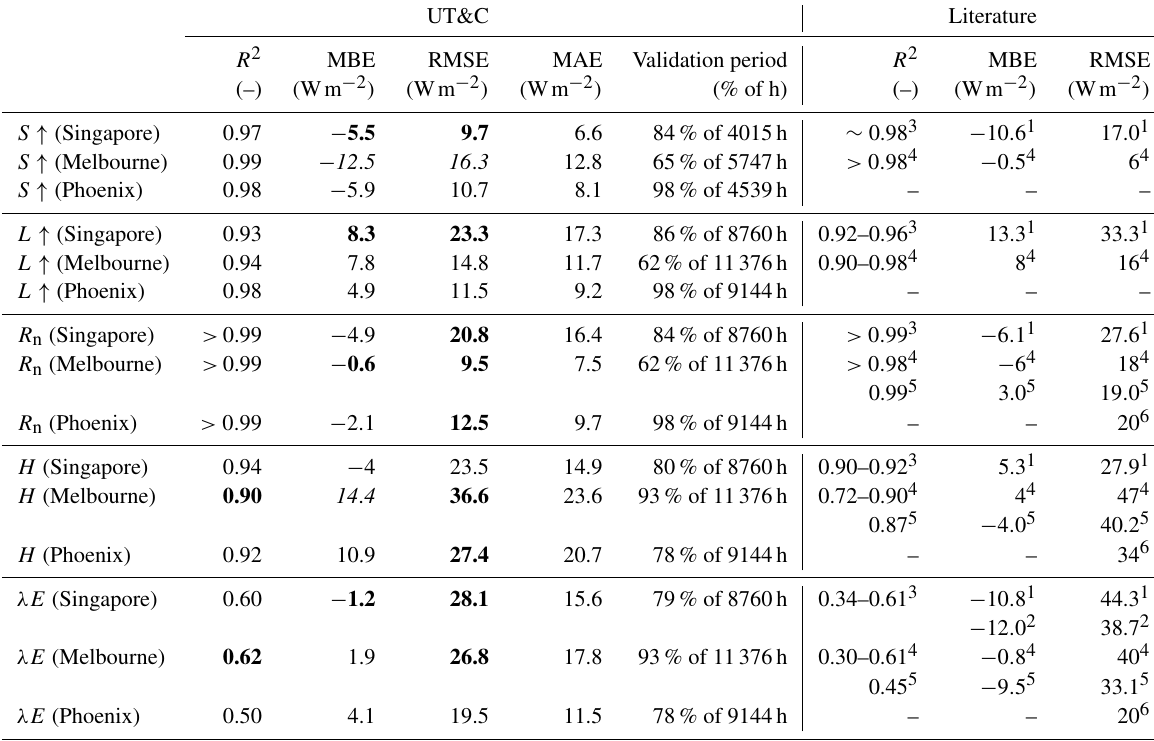
Table 2. Coefficient of determination ( R 2 ), mean bias error (MBE), root mean square error (RMSE), and mean absolute error (MAE) of the UT&C model performance assessment in Singapore, Melbourne, and Phoenix, and comparison with literature values assessing urban canopy models in the same locations. The validation period specifies the total UT&C simulation period in hours (h) and the percentage of time with available eddy-covariance measurements for model performance assessment. Values marked in bold specify an improved and italic a decreased model performance of UT&C compared to values reported in literature.